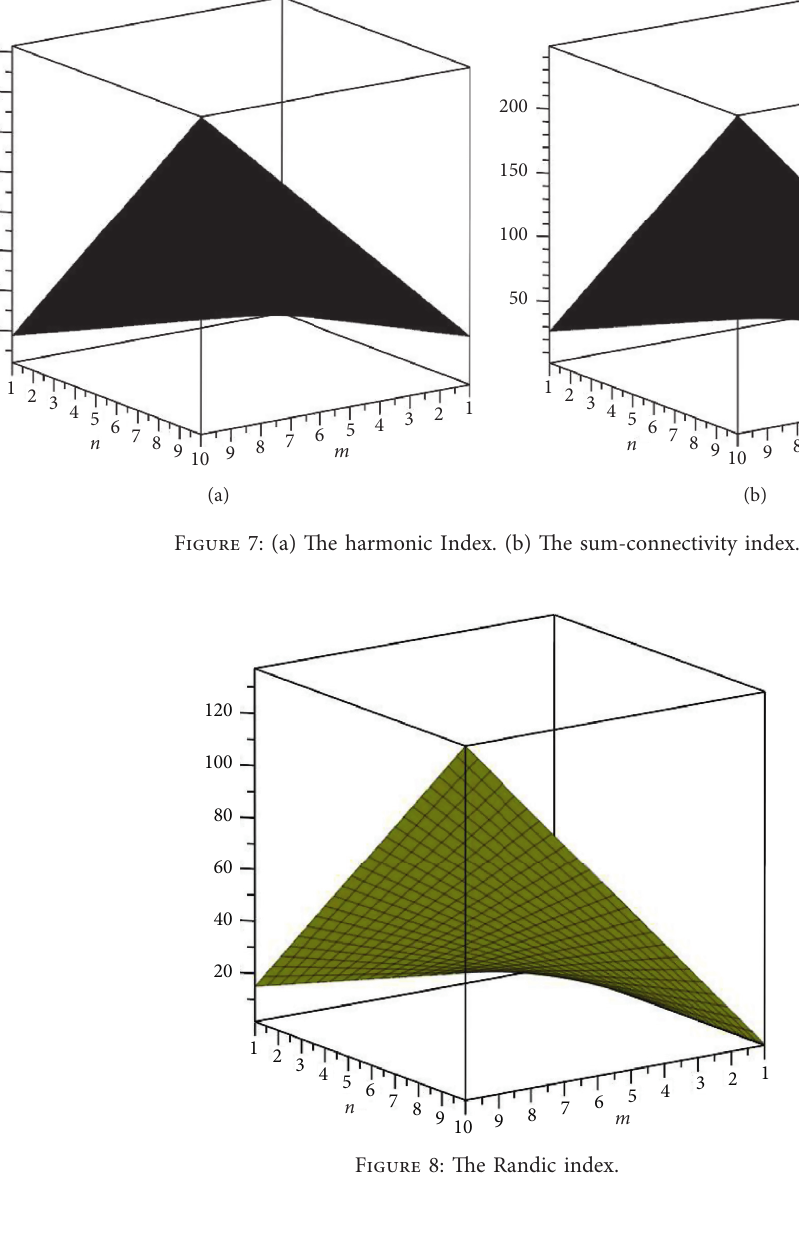
Table 7: Numerical representation of the computed indices for certain values of m and n .